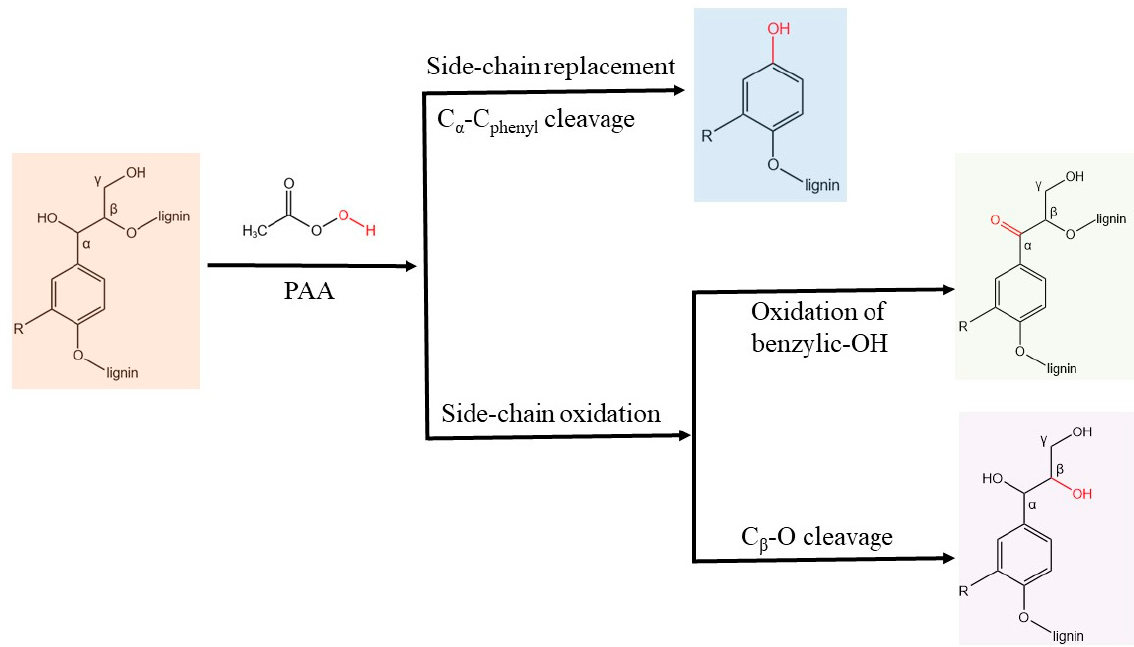
Figure 4. The depolymerization pathway of dilute acid pretreated corn stover lignin (DACSL) by PAA.